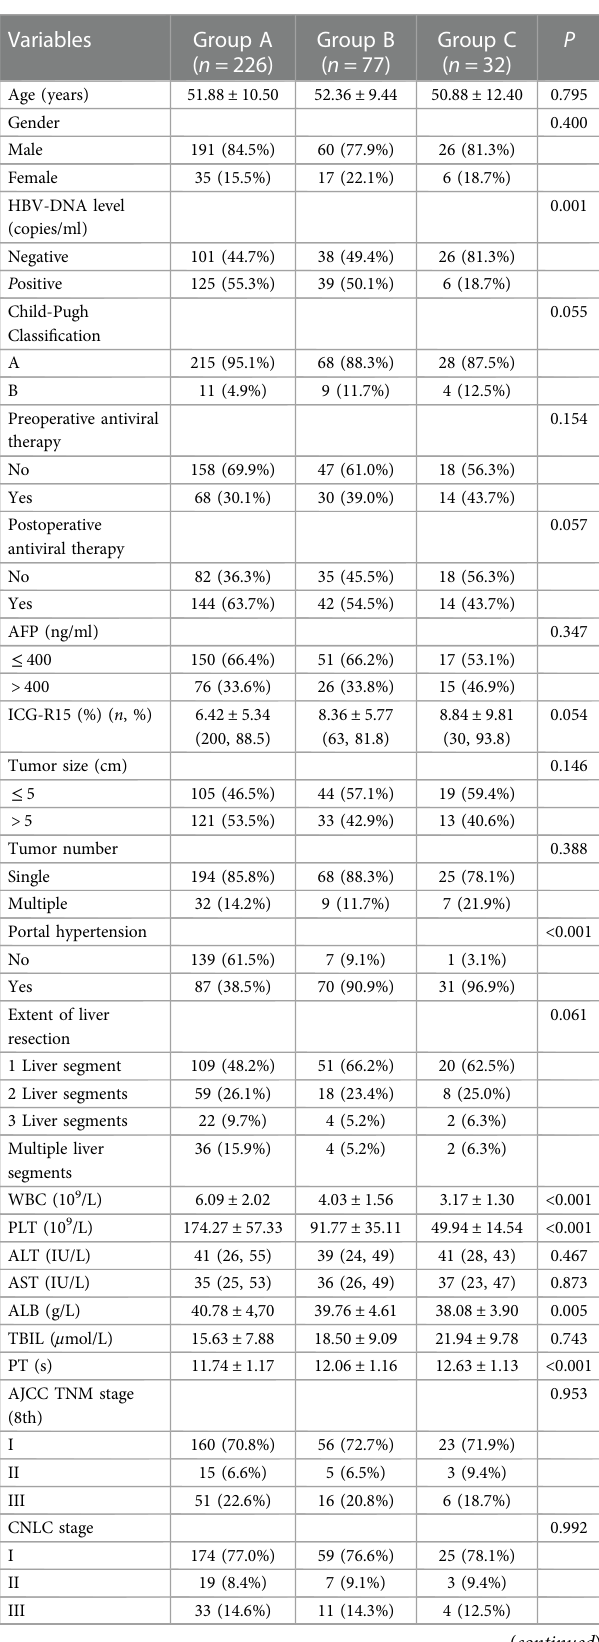
TABLE 1 Baseline